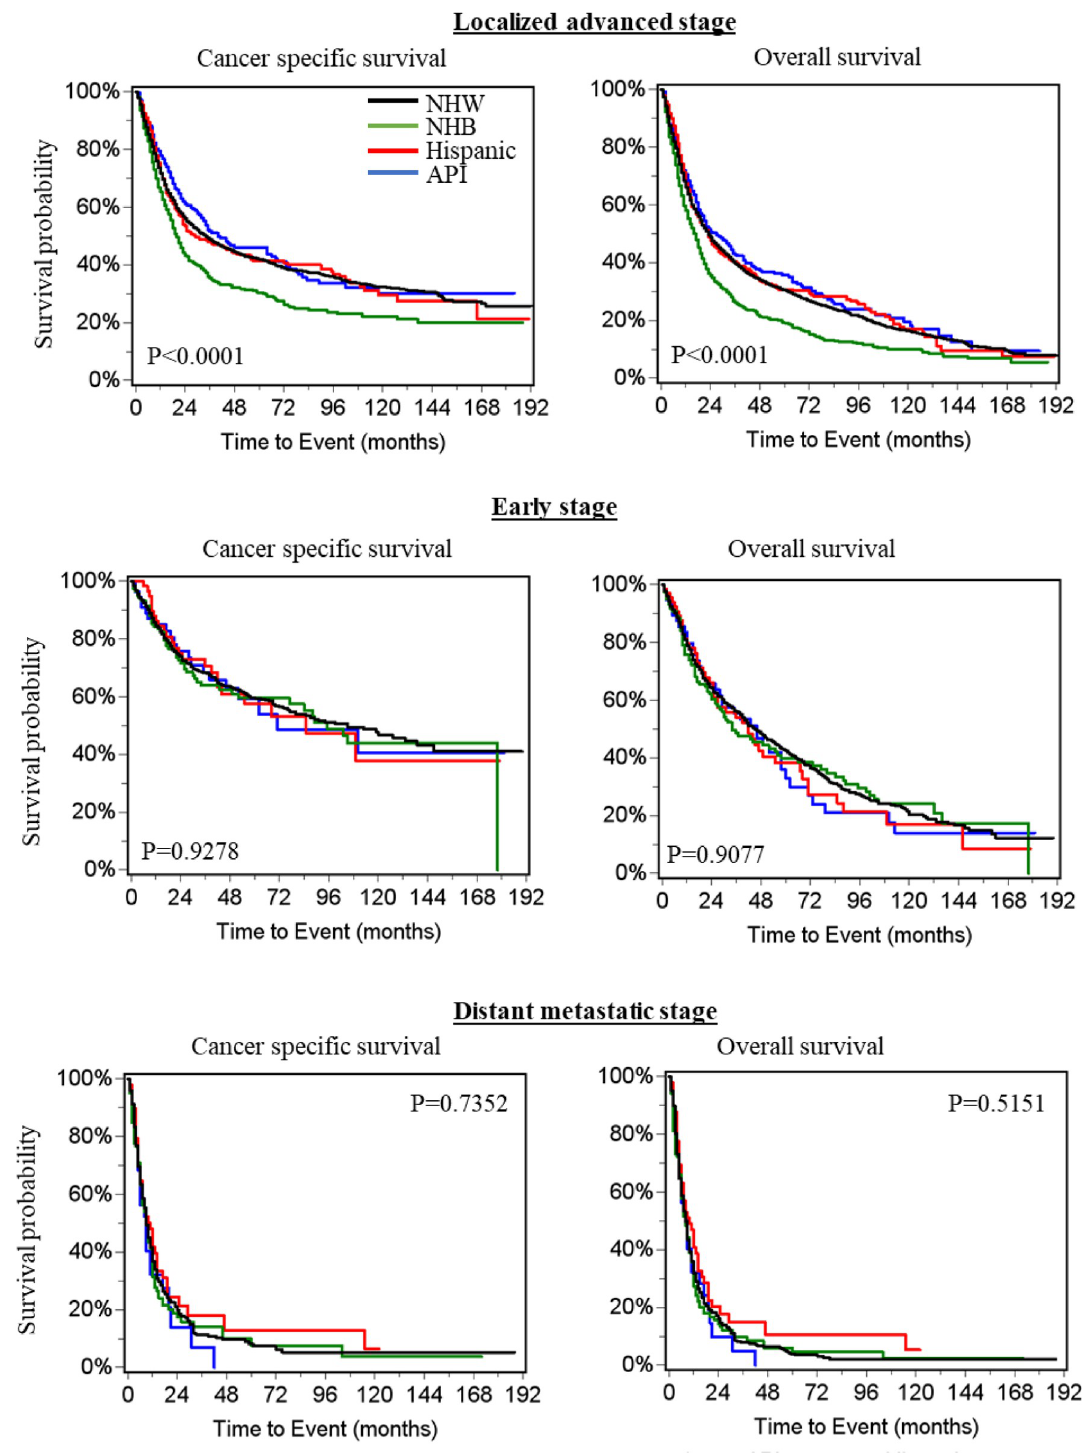
Fig 3. Kaplan–Meier survival curves for patients with stage T1 colorectal cancer in patients with hypopharyngeal squamous cell carcinoma (HPSCC) by stage and race. API, Asian or Pacific Islander; NHB, non-Hispanic black; NHW, non-Hispanic white.